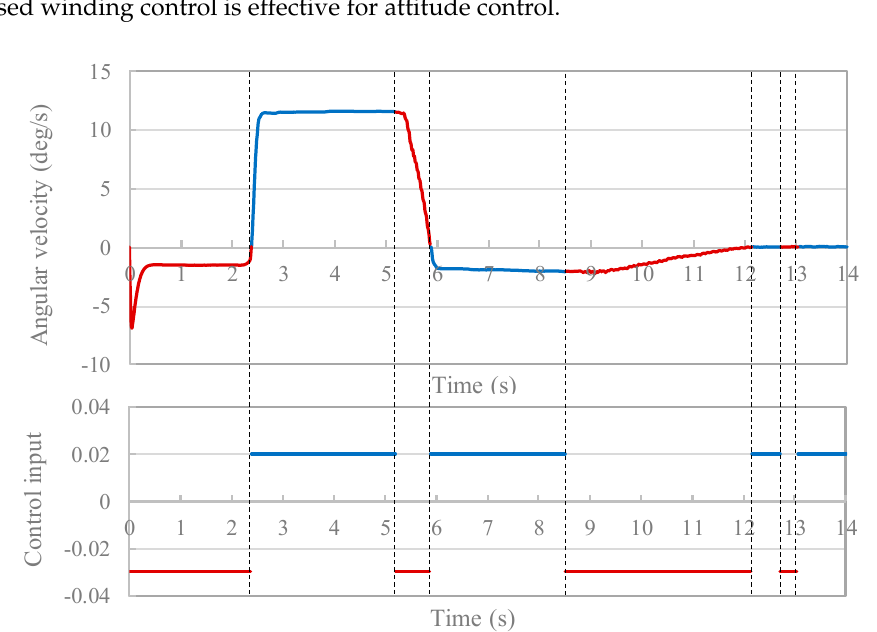
Figure 19. Time history of angular velocity and control input (control 1).